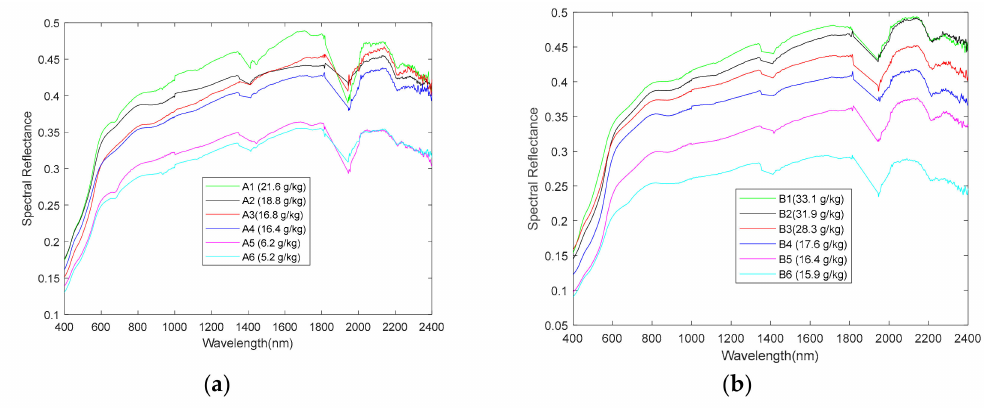
Figure 7. Spectrum reflectance of di ff erent salinization level sampling points. ( a ) Area A. ( b ) Area B.